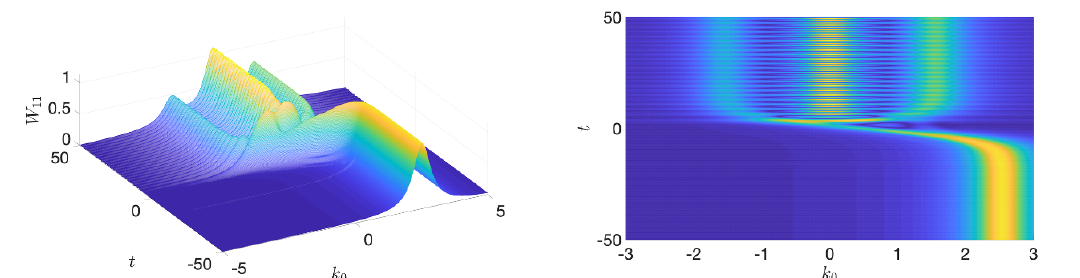
Figure 4. Shown is the absolute value of the (1 ; 1)-component of the exact free Wightman function W > de(cid:12)ned in equation (3.11), for parameters h = 1, j k j = 0 : 4, m 1R = 0 : 5, m 2R = 2, m I = h k ; (cid:0) (cid:0) 0 : 005, (cid:28) w = 5 and (cid:0) = 0 : 4. Note that time (cid:13)ows from bottom to top in the right panel.